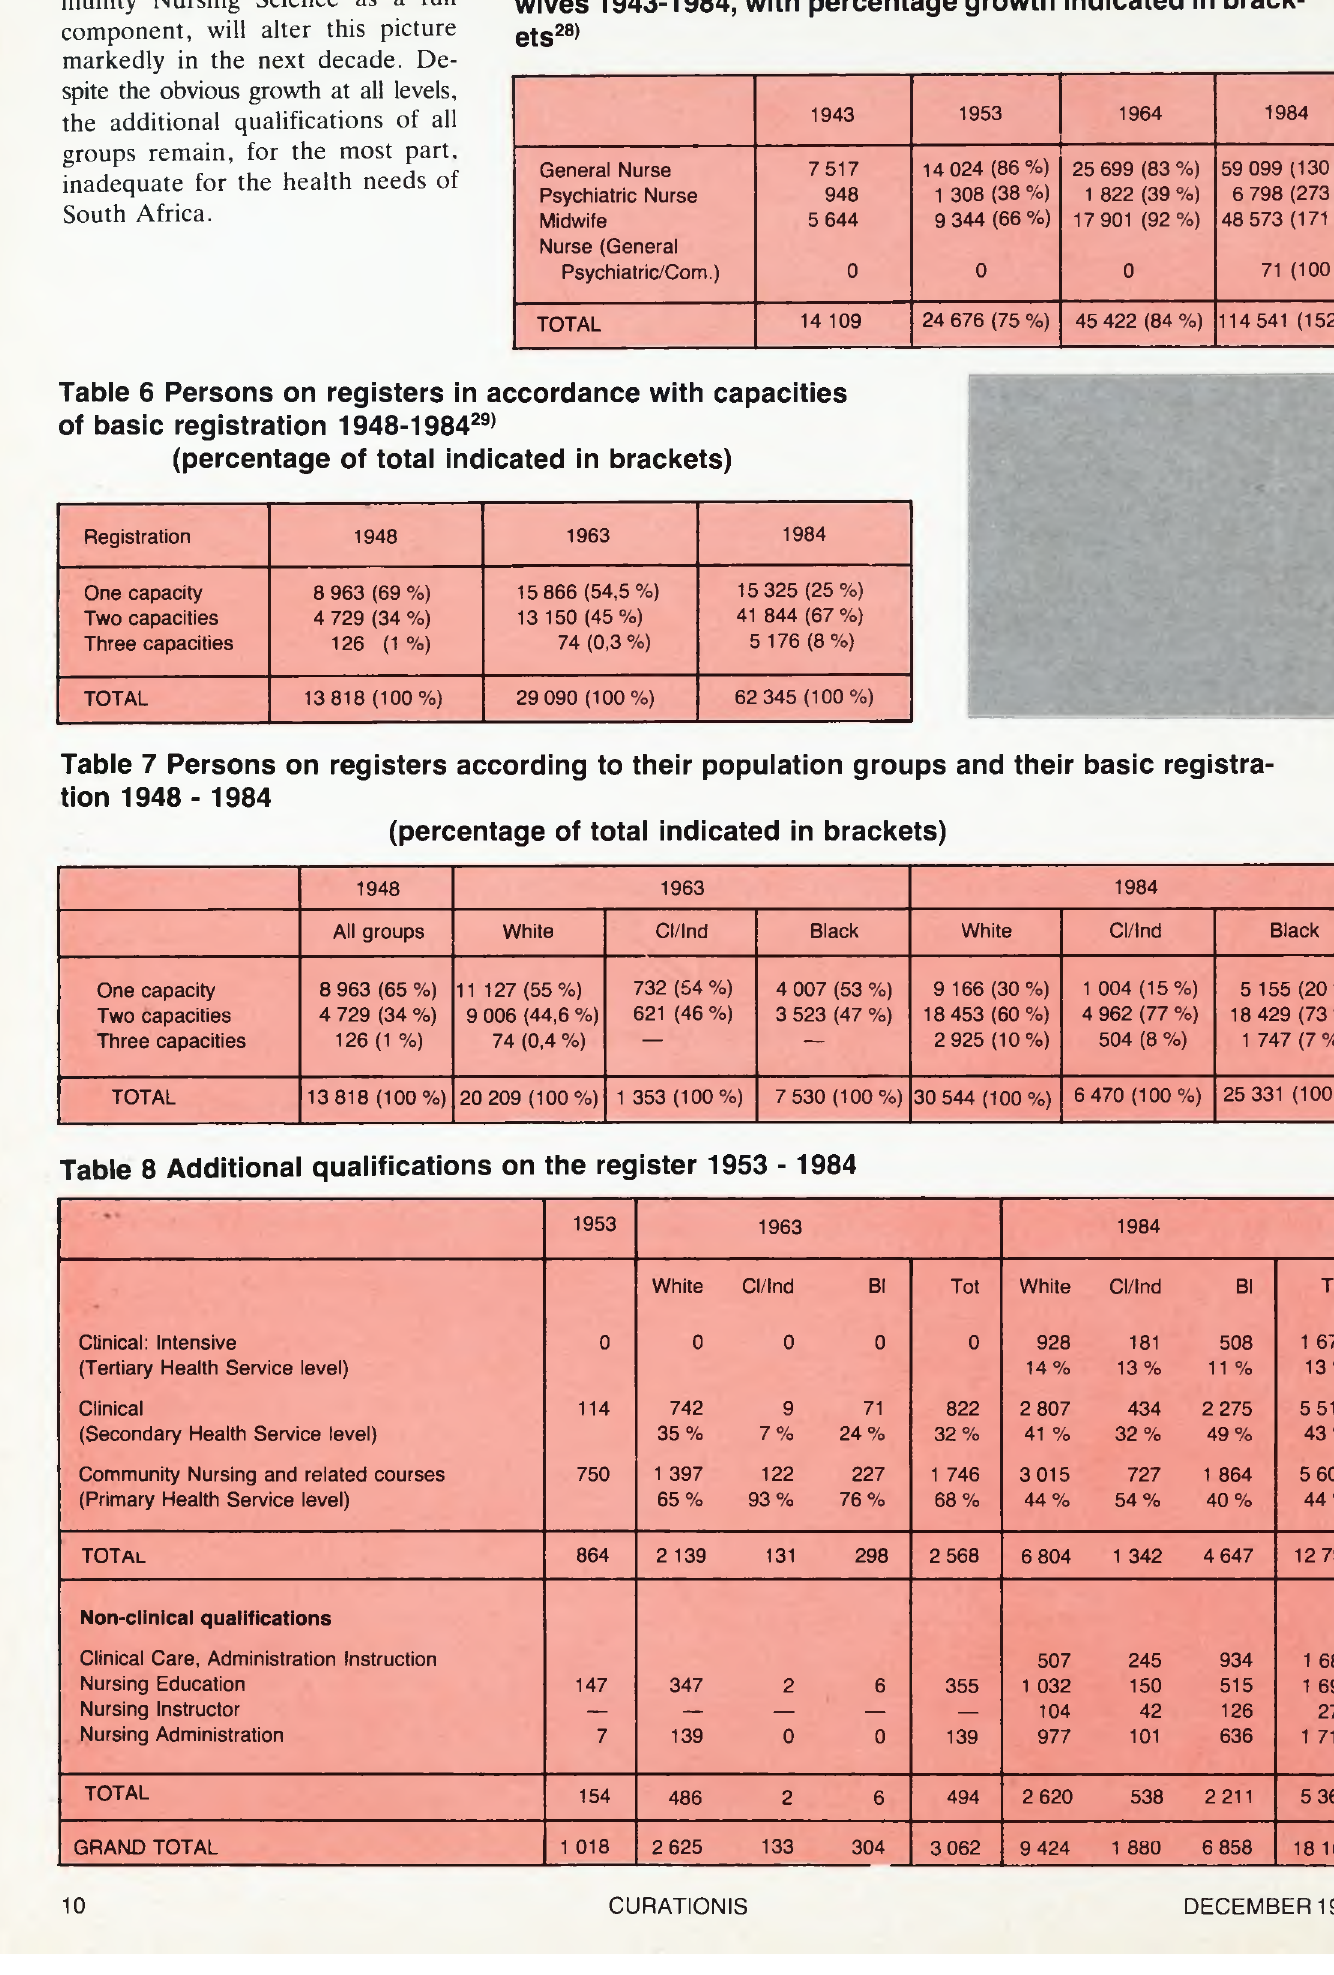
Table 8 Additional qualifications on the register 1953 -